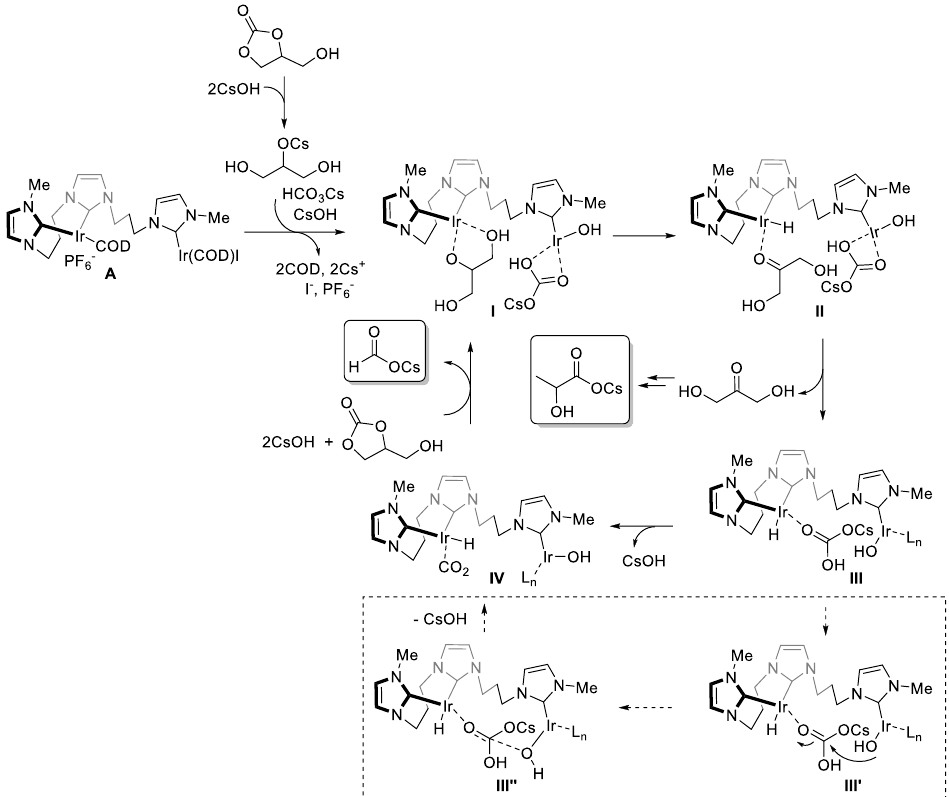
Figure 1. Gas analysis from the reaction mixture of glycerol carbonate, catalyst A , and CsOH.